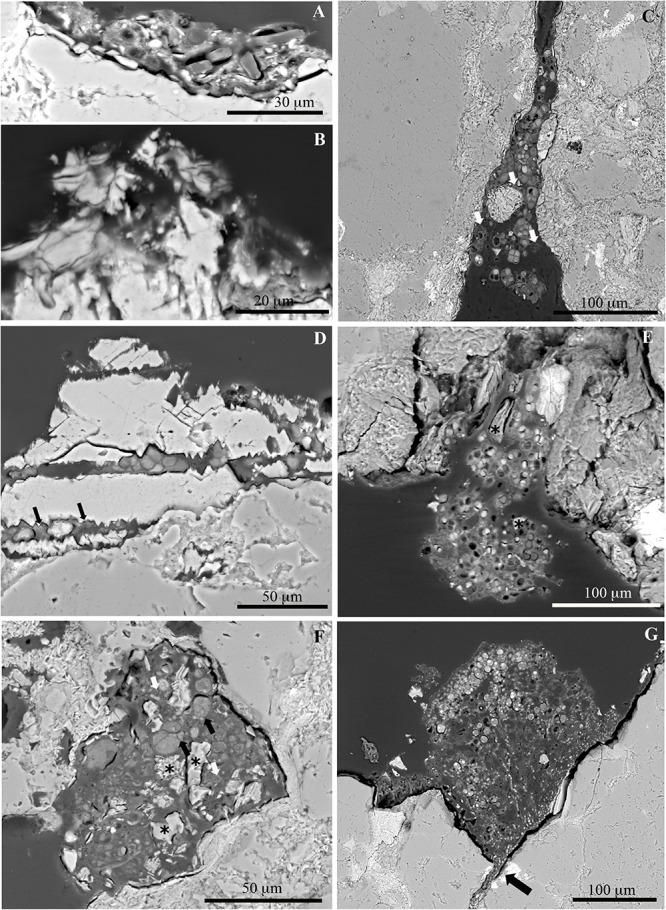
SEM-BSE images of different succession stages of microbial and lichen colonization of moraine rocks. Diatom cells (A) and grain mineral matrix (B) situated on the rock surface at rocks close to the glacier forefront. Endolithic cyanobacteria-dominated communities (C) and algal communities (D) at rocks being ice-free for ca. 13 years. Arrows indicate the presence of non-photosynthetic bacterial cells in both microbial communities. Endolithic cyanobacteria-dominated communities in fissures (E), and mixed microbial communities inside epilithic cavities (F) of rocks being ice-free for ca. 23 years; these contain small mineral fragments (∗) which could be the result of microbial-mineral interactions. Black arrows in (F) indicate lichen mycobiont-photobiont interactions. Colonization of an epilithic lichen thallus on a rock being ice free for ca. 23 years (G), showing endolithic penetration of mycobiont cells (black arrow).